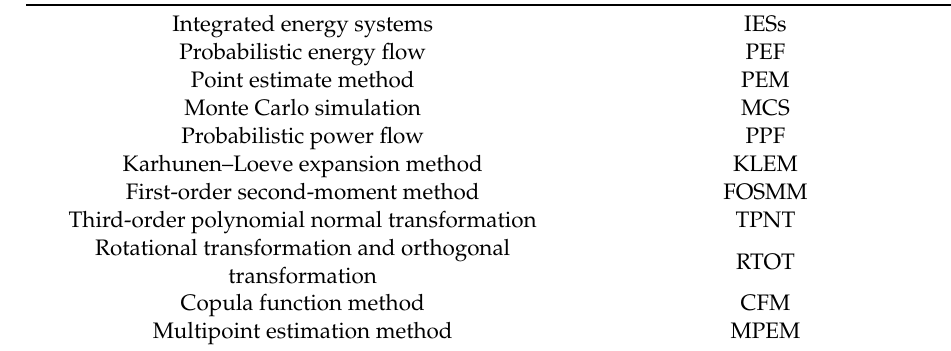
Table A1. Nomenclature and abbreviations.